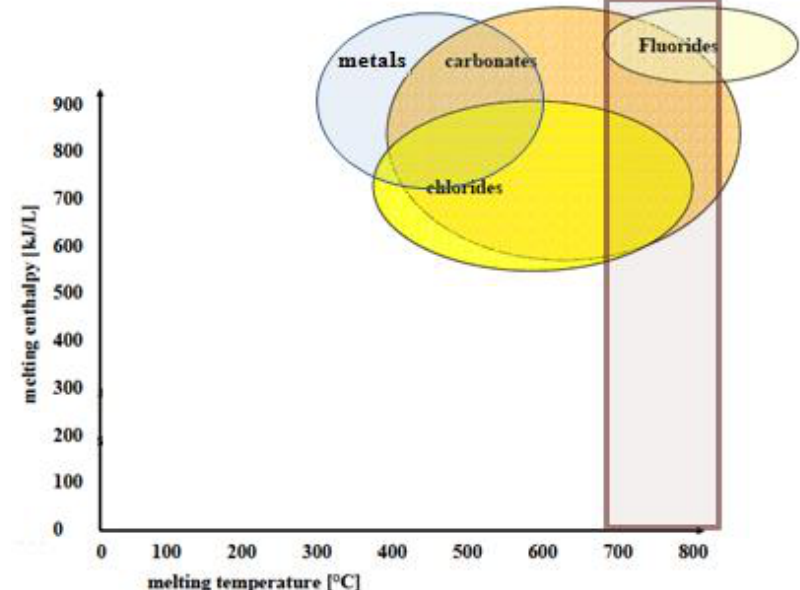
Figure 1. Families of PCMs depending on the melting temperature and its